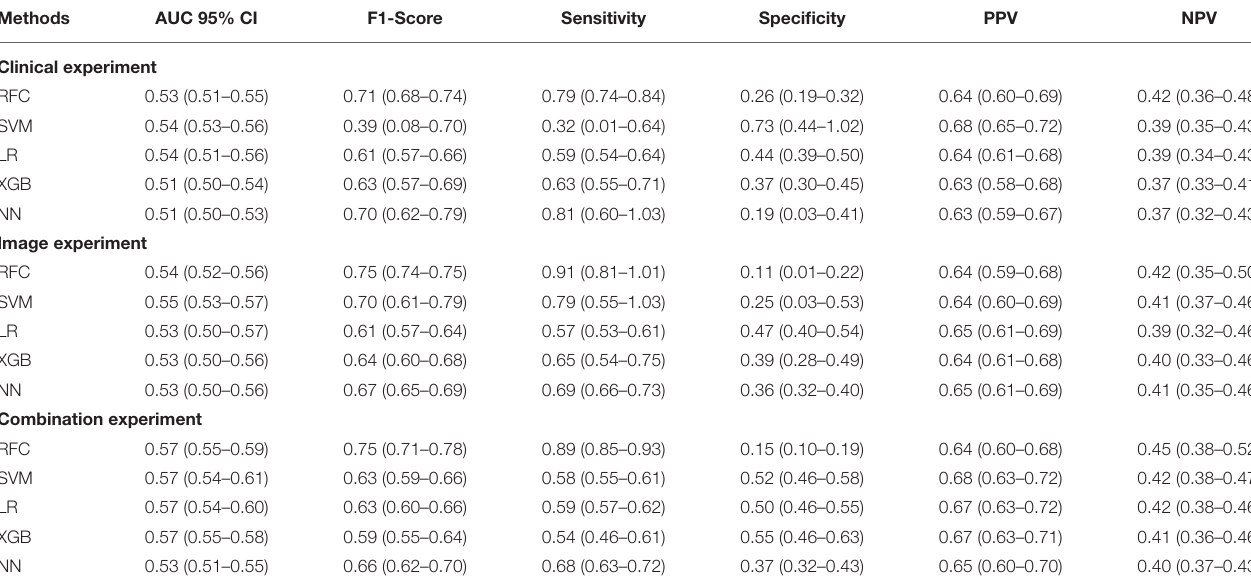
TABLE 3 | Results of the clinical, image, and combination experiments for the radiomics approach for predicting the good reperfusion [post-modified Thrombolysis in Cerebral Infarction (eTICI) ≥ 2b].